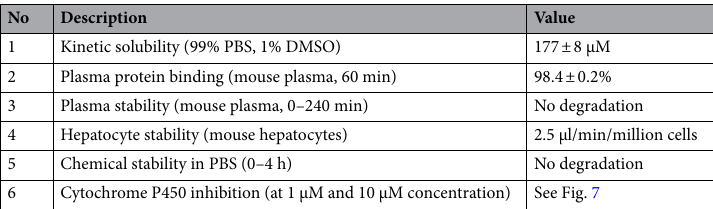
Table 2. Physicochemical and in vitro pharmacokinetic properties of 7.44.